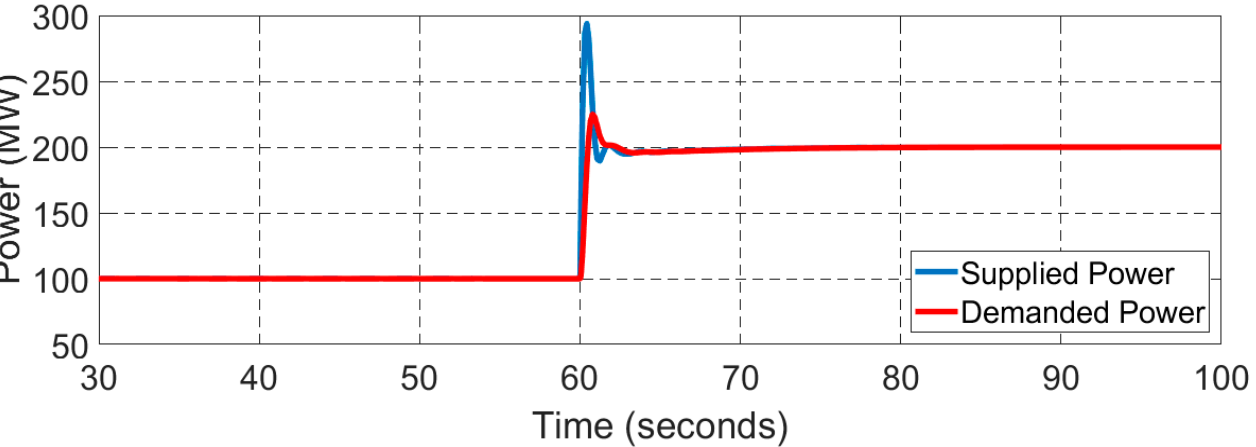
Figure 16. The active power mismatches between the supplied power and demanded power in Area 1.